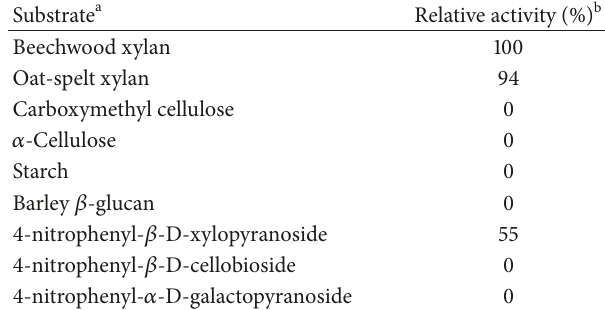
Table 1: Substrate specificity of the purified recombinant XynA MG